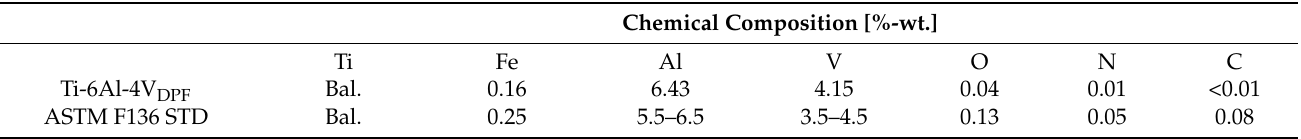
Table 3. Average OES chemical analysis of the produced NNS stems.